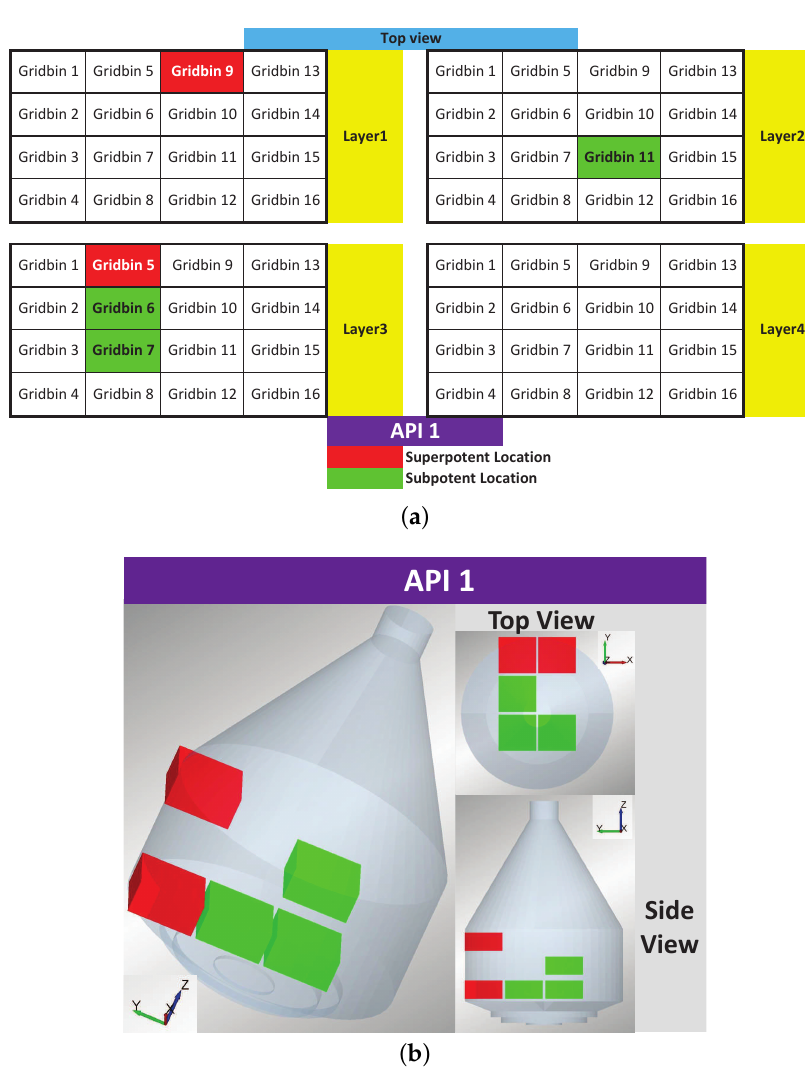
Figure 6. Super-potent and sub-potent regions in the mixing of API 1 represented as: ( a ) the Cartesian system; ( b ) 3D